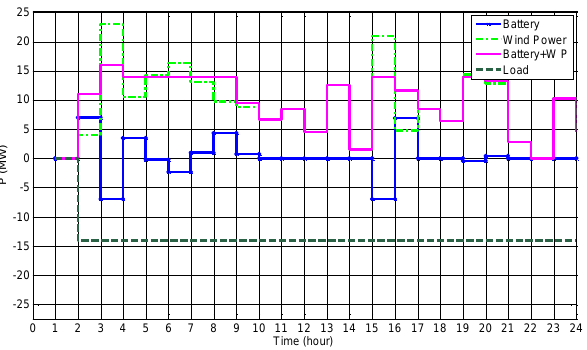
Fig.7 . Reference values of active power